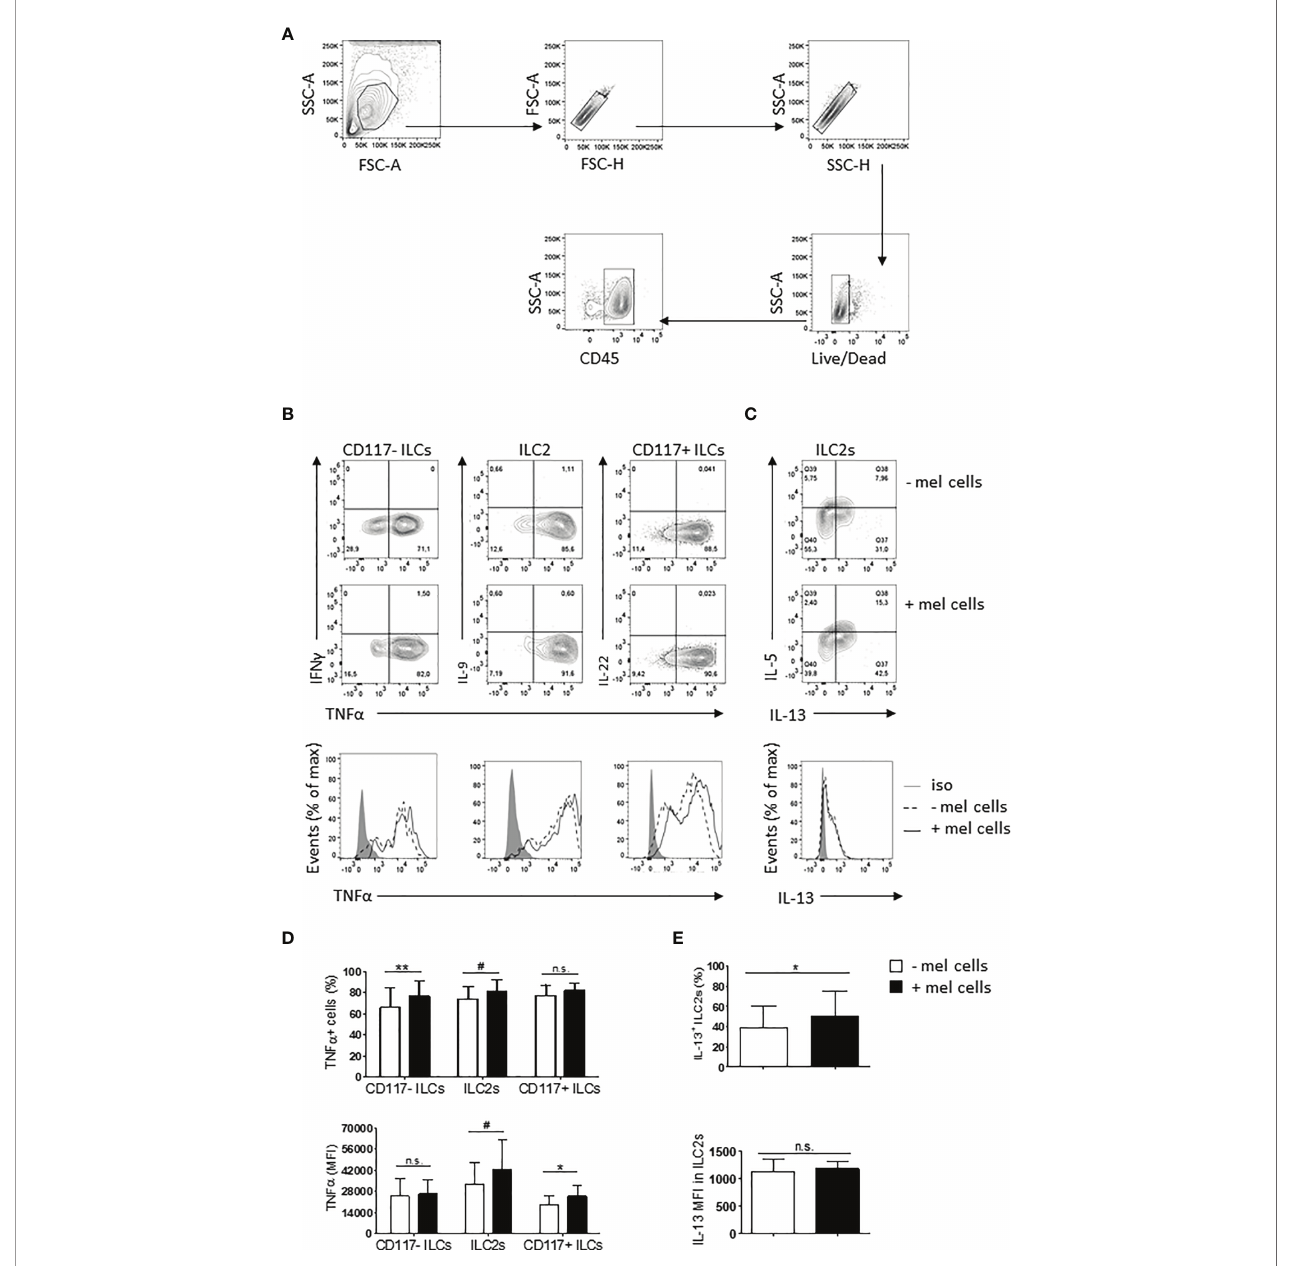
FIGURE 4 | Cross-talk between ILC subsets and melanoma cells in vitro . (A) Gating strategy used to identify ILCs within co-cultures. (B, C) Representative plots of TNF a up-regulation in all the three ILC subsets (B) and IL-13 up-regulation in ILC2s (C) co-cultured with melanoma cells at 5:1 ratio for 3 days. (D, E) Percentage of positive cells (upper lines) and expression (lower lines) of TNF a in all the three ILC subsets (D) and of IL-13 in ILC2s (E) . Cumulative data derived from eight independent experiments performed using two different melanoma cell lines are shown as mean ± SD. For each cell line, at least three independent experiments were carried out. Analysis was performed by paired Student t test. **p-value < 0.01; *p-value < 0.05; # p-value < 0.1. n.s. stand for Not Signi fi